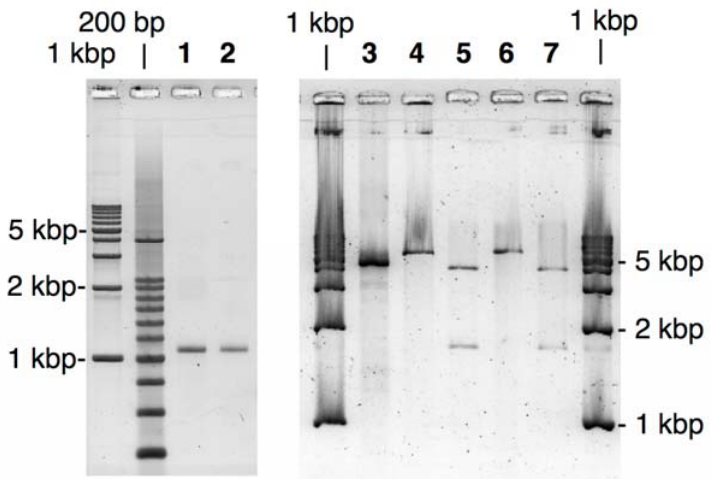
Figure 2. Agarose-gel analysis of LACE-PCR products and the extracted recombinant plasmids for GFP- and BFP-recombinants. Lane 1, GFP fragment; Lane 2, BFP fragment; Lane 3, the vector fragment; Lane 4, GFP recombinant linearized with EcoRI ; Lane 5, GFP recombinant treated with BamHI ; Lane 6, BFP recombinant linearized with EcoRI ; Lane 7, BFP recombinant treated with BamHI